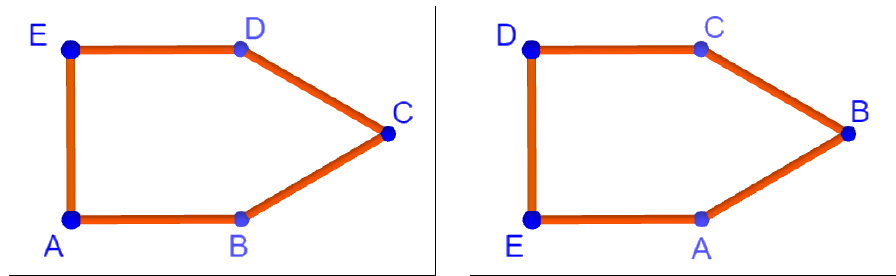
Figure 2. Two non-congruent realizations of a linkage with 5 vertices and 5 unit-length edges.